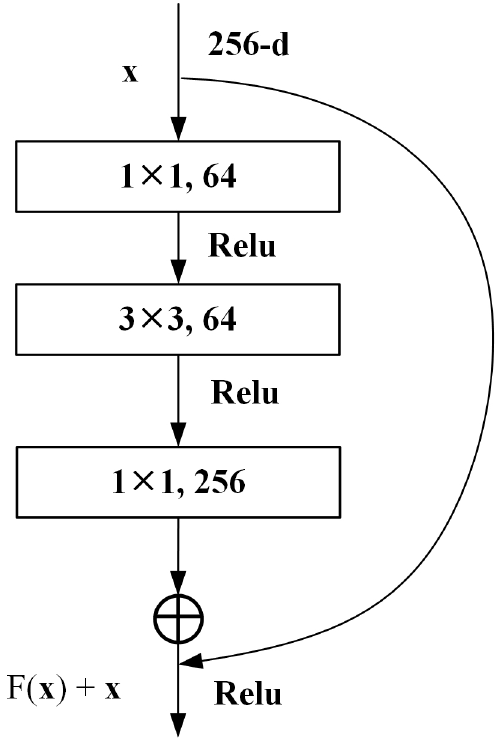
Figure 5. Basic residual block.